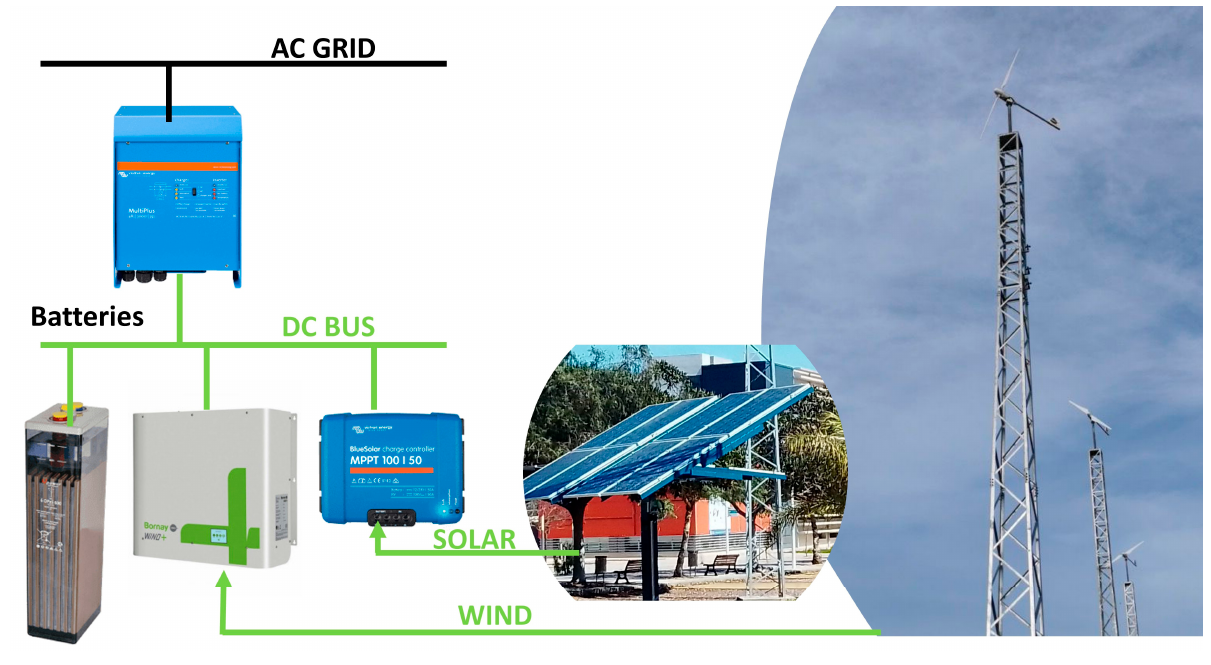
Figure 2. Laboratory